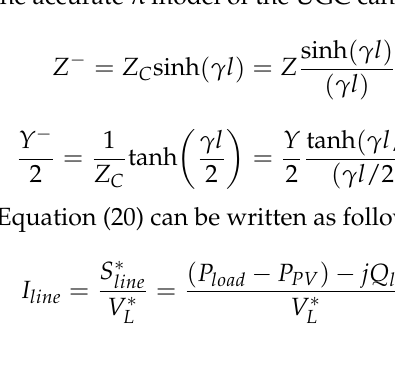
Figure 5. Modified π equivalent circuit of Underground Cable (UGC).